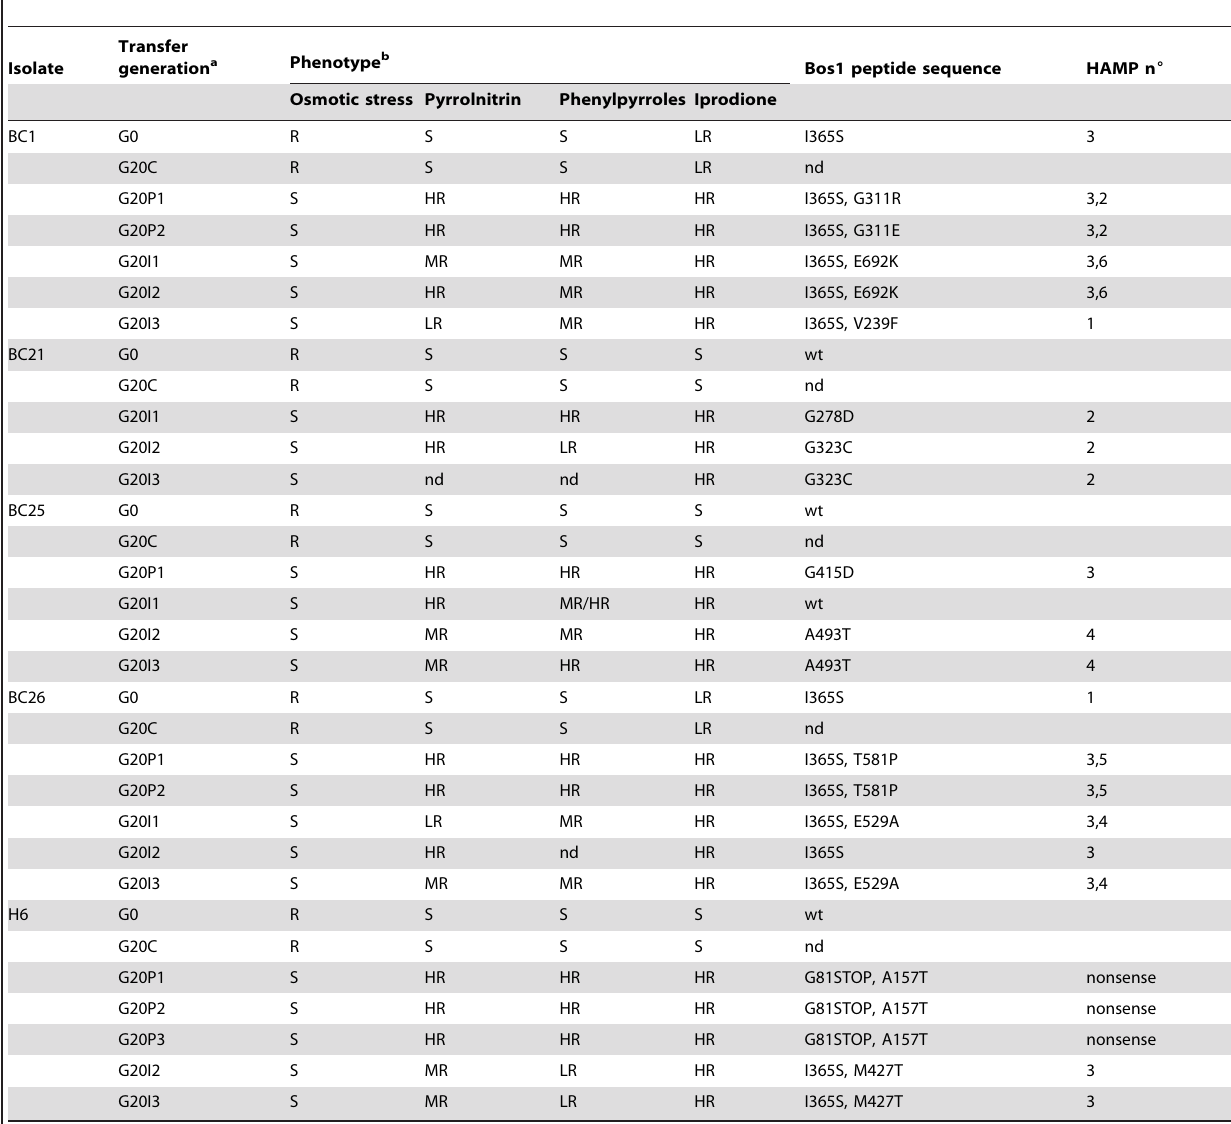
Table 1. Phenotypes and changes in Bos1 peptide sequence in pyrrolnitrine- and iprodione-induced mutants.